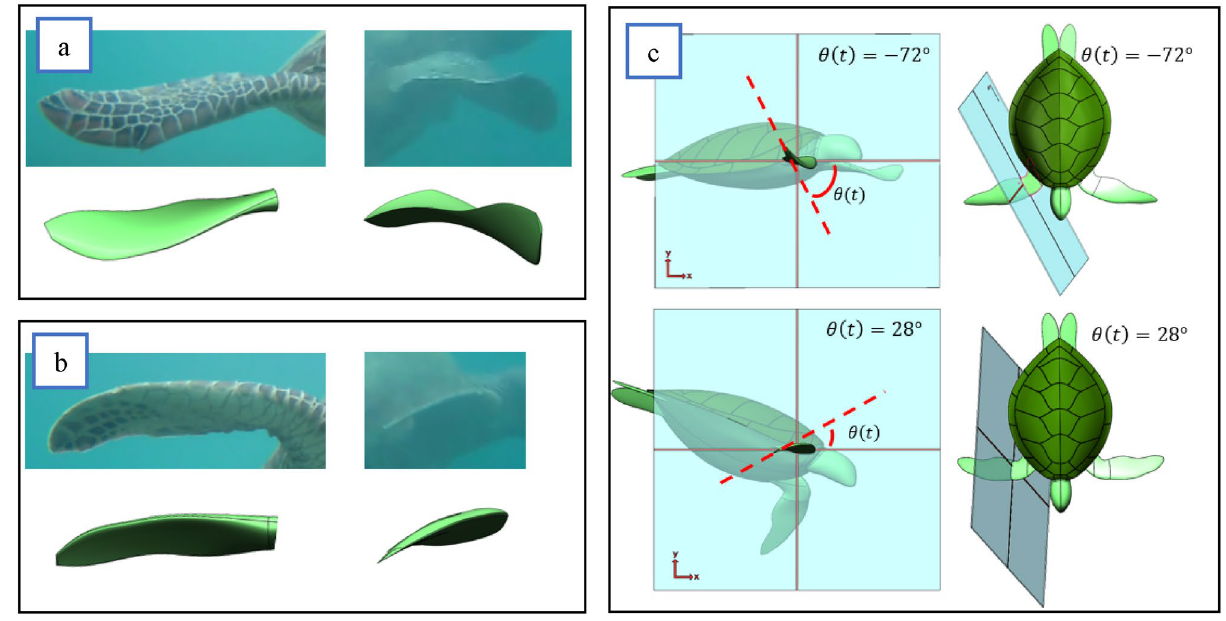
Figure 5. Flipper twist. ( a ), Downstroke twist of − 72°; ( b ), Upstroke twist of 28°; ( c ), Reference plane with 0° being inline with the horizontal x-axis of the elbow cross-section, additionally showing how the plane moves with the turtle flipper to remain normal to the rotation